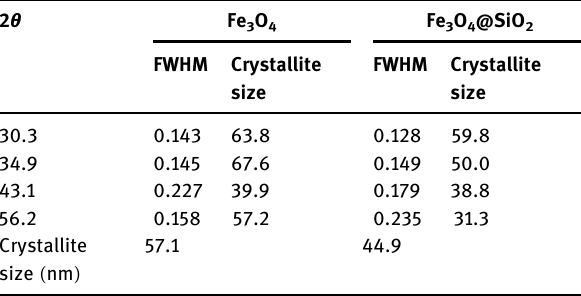
Table 2: Calculated crystallite size from XRD